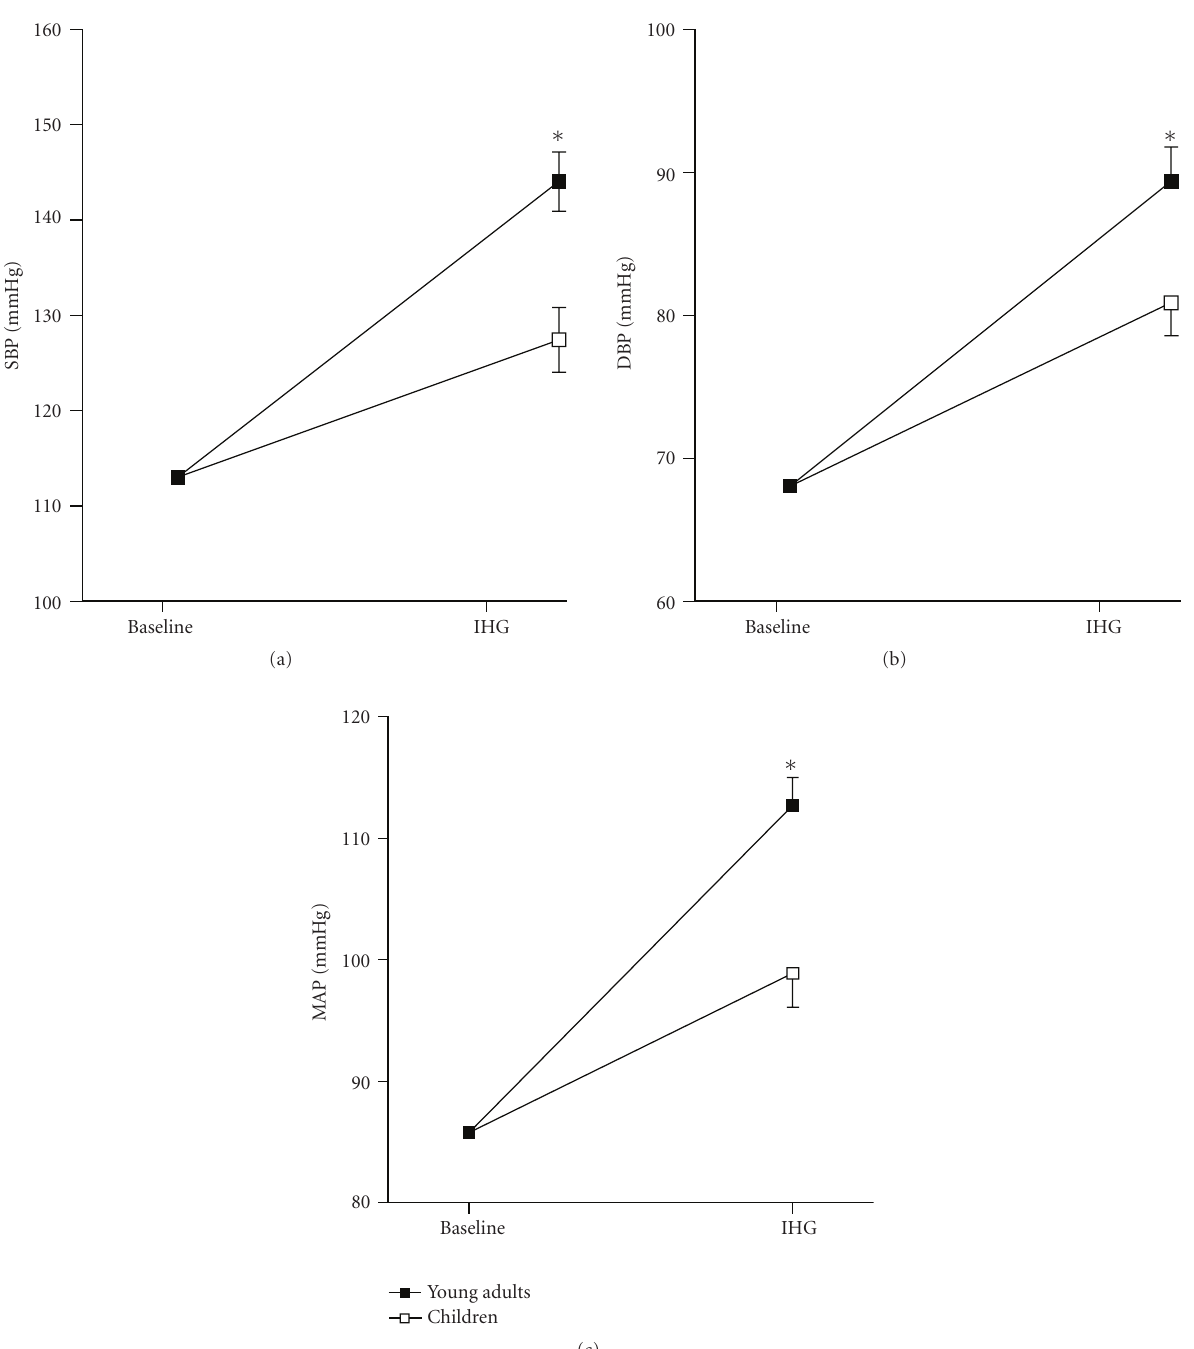
Figure 1: Systolic blood pressure (a), diastolic blood pressure (b) and mean arterial pressure (c) responses to isometric handgrip exercise in children and young adults. SBP: systolic blood pressure; DBP: diastolic blood pressure; MAP: mean arterial pressure; IHG: isometric handgrip exercise. The adjusted means (adjusted to the influence of the covariates) are presented as means ± SE. ∗ P < . 05, task by group